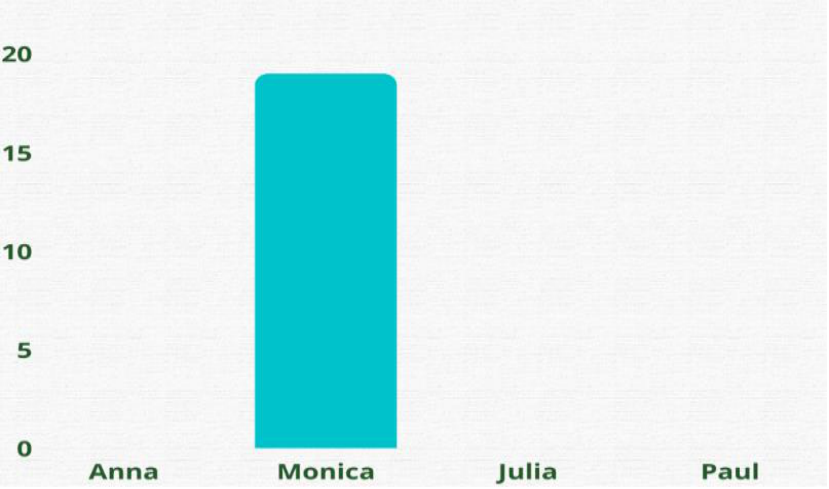
Figure A3. Which Persona Does Not Fit a Mental Health Nurse at All (n = 19)? Note: option to choose more than one